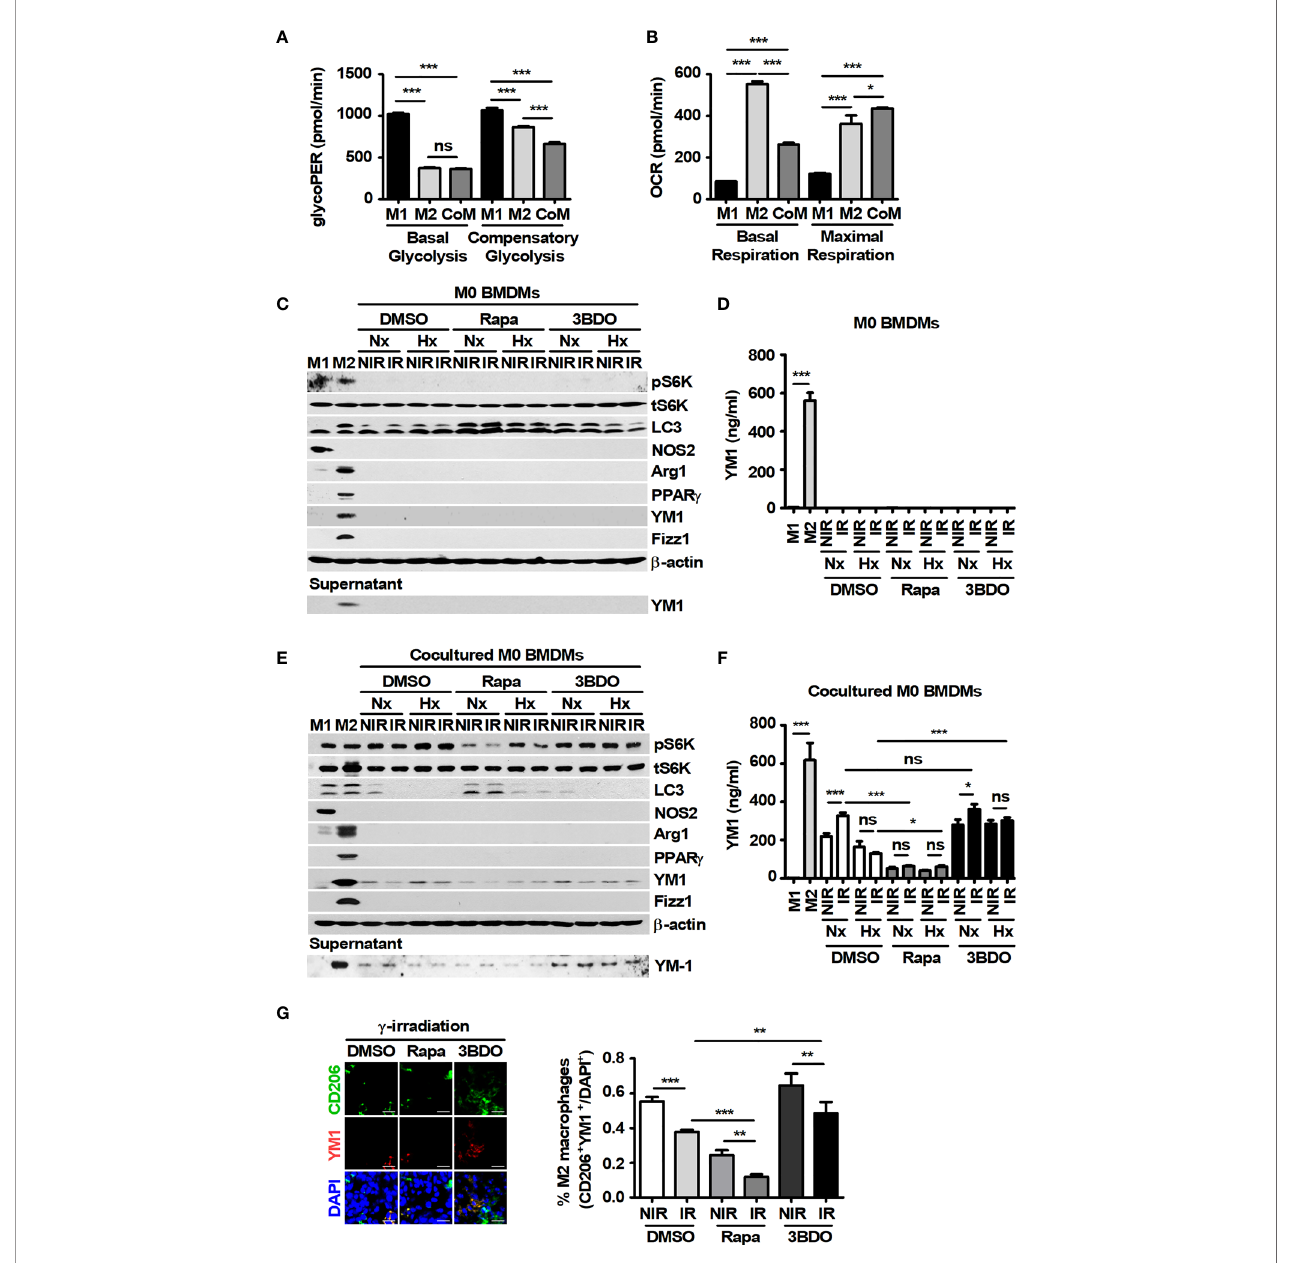
FIGURE 3 | Pharmaceutical regulation of mTOR activation affects YM1-expressing macrophages cocultured with B16F10 cells. (A, B) BMDMs were treated with 100 ng/ml LPS plus 20 ng/ml IFN- g or 20 ng/ml IL-4, or were cocultured with B16F10 cells for 24 h, and then the glycolytic proton ef fl ux rate (GlycoPER) (A) or the oxygen consumption rate (OCR) (B) in the cells was analyzed. (C – F) BMDMs were polarized into the M1 (LPS+IFN- g ) and M2 (IL-4) phenotypes. M1-, M2-, M0- and B16F10-cocultured BMDMs were incubated under the indicated conditions. The protein levels of p70 S6K, phospho-p70 S6K, LC3, NOS2, Arginase-1, PPAR- g , YM-1, Fizz-1, and b -actin in BMDMs were evaluated by western blotting. Secreted YM-1 in the supernatant was detected by western blot and ELISA. (G) Intratumoral levels of CD206 and YM-1 were analyzed by confocal microscopy. CD206 + YM1 + cells in tissue samples were assessed by ImageJ. The bars and error bars represent the mean ± SD; * P < 0.05; ** P < 0.01; *** P < 0.001; ns, not signi fi